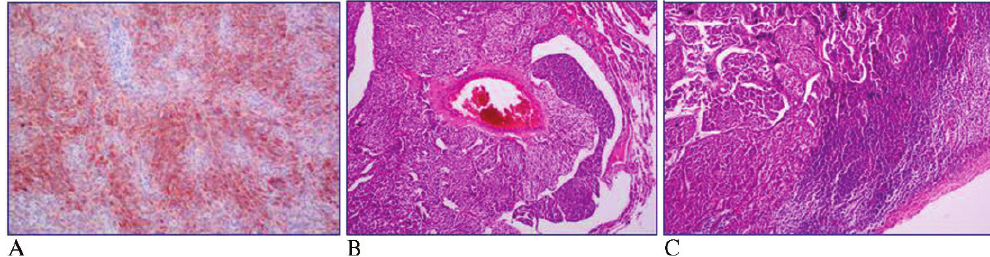
Figure 3 - A) ACTH staining of bronchial cells. B) Vascular invasion by tumor cells. C) Lymphoid invasion by